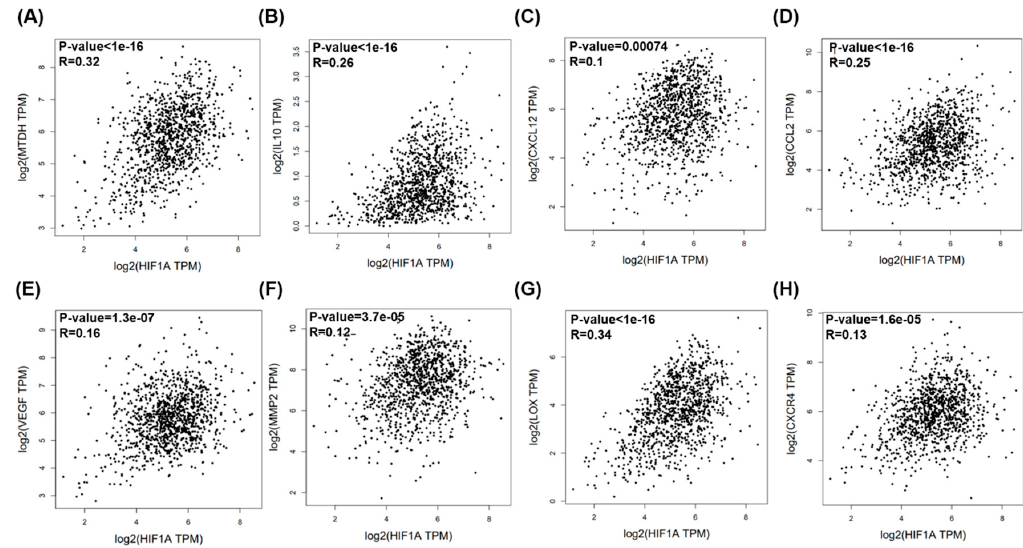
Figure 1. Metadherin (MTDH), interleukin (IL)-10, C-C motif chemokine ligand 12 (CCL12), C-C motif chemokine ligand 2 (CCL2), vascular endothelial growth factor (VEGF), matrix metallopeptidase 2 (MMP2), lysyl oxidase (LOX), and C-X-C chemokine receptor type 4 (CXCR4) mRNA expressions and their correlations with hypoxia-inducible factor (HIF)-1 α in breast cancer patients using the The Cancer Genome Atlas (TCGA) web server program. Pearson’s correlations between HIF1- α expression